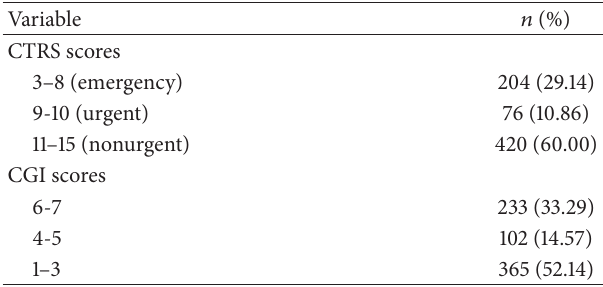
Table 2: Pattern of CTRS and CGI scores ( 𝑁 = 700